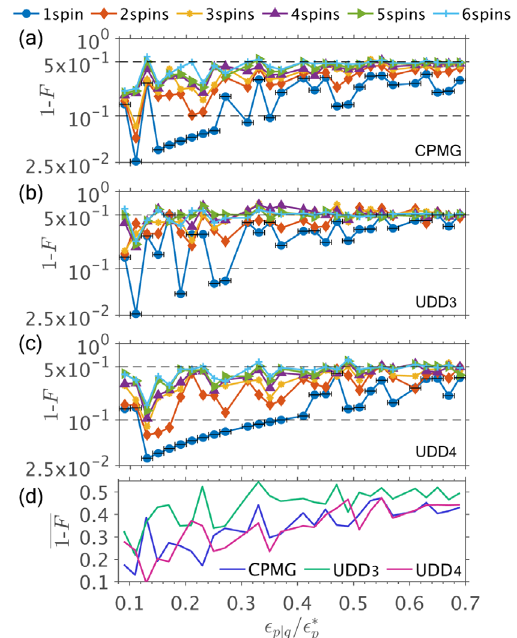
FIG. 17. Gate error 1 − F as a function of one-tangles (scaled by 2 = 9 ) of unwanted nuclei for (a) CPMG, the maximum value ϵ (cid:3) p ¼ (b) UDD 3 , and (c) UDD 4 . The labels in all graphs show up to how many spins are “ traced out ” from the total system. The unwanted spins have one-tangles in the range [0.1, 0.7]. The error bars of the blue points show the intervals where we assign unwanted spins and are the same for all differently colored lines. The gate error shown in (a) – (c) is the average over eight different ensembles of unwanted nuclei for each bath size. In (d), we take the gate error from (a) – (c), respectively, and further average over the six different unwanted spin baths for each one-tangle range (see the text).